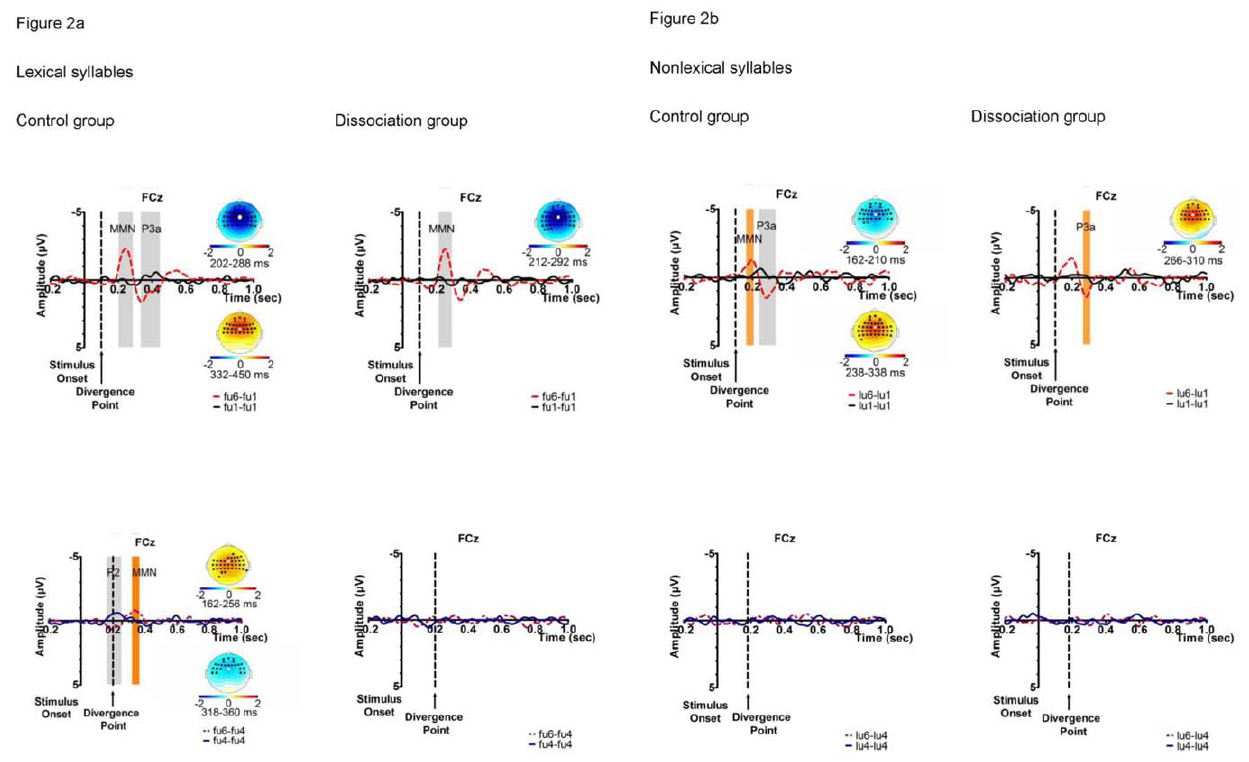
Figure 2. Panel A. Tonal contrasts of lexical syllables. Panel B. Tonal contrasts of nonlexical syllables. Note . Grand-averaged difference waves and dummy waves at the FCz electrode for illustration, with significant clusters (statistically significant ones in grey and clusters uncorrected for multiple comparisons in orange) considered as MMN or P3a components and their corresponding topographs (significant electrodes in black and FCz in